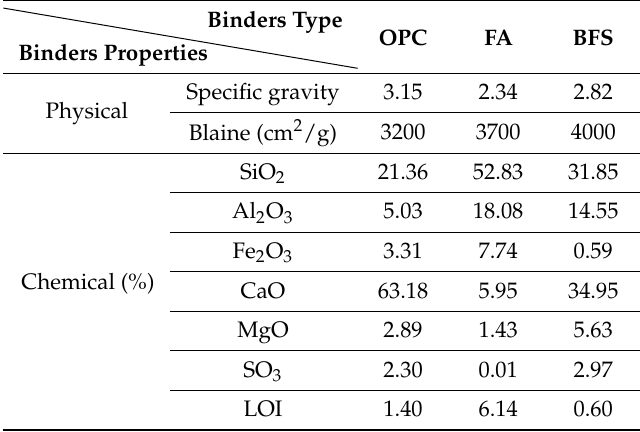
Table 1. Physical and chemical compositions of the